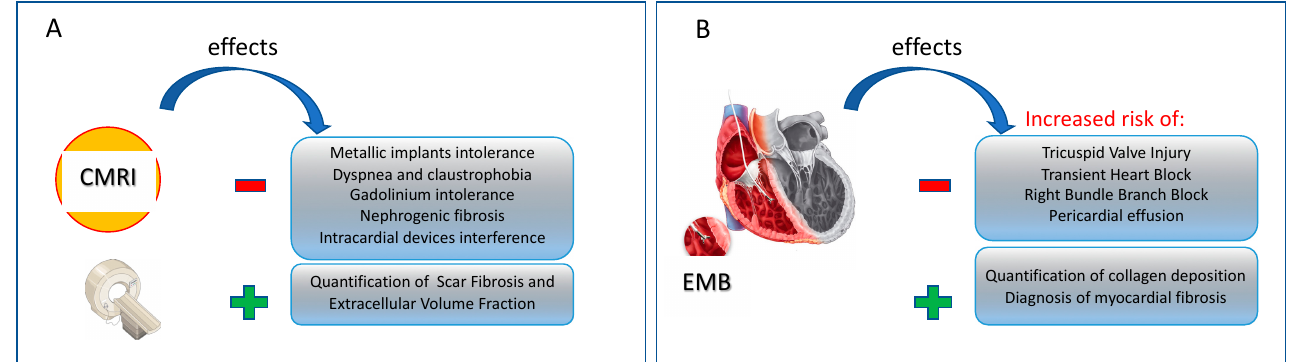
Figure 1. ( A , B ) Major negative and positive effects with the use of the non-invasive ( A ) and invasive ( B ) techniques able to identify fibrotic deposition in myocardium. CMRI: cardiac myocardial resonance imaging; EMB: endomyocardial biopsy.